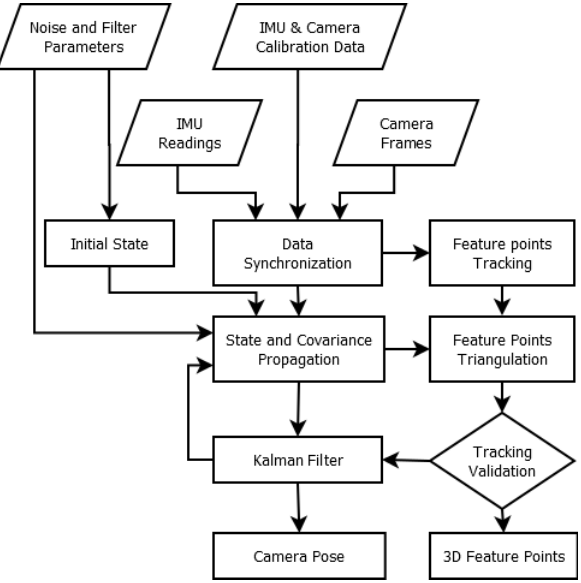
Figure 6: Visual